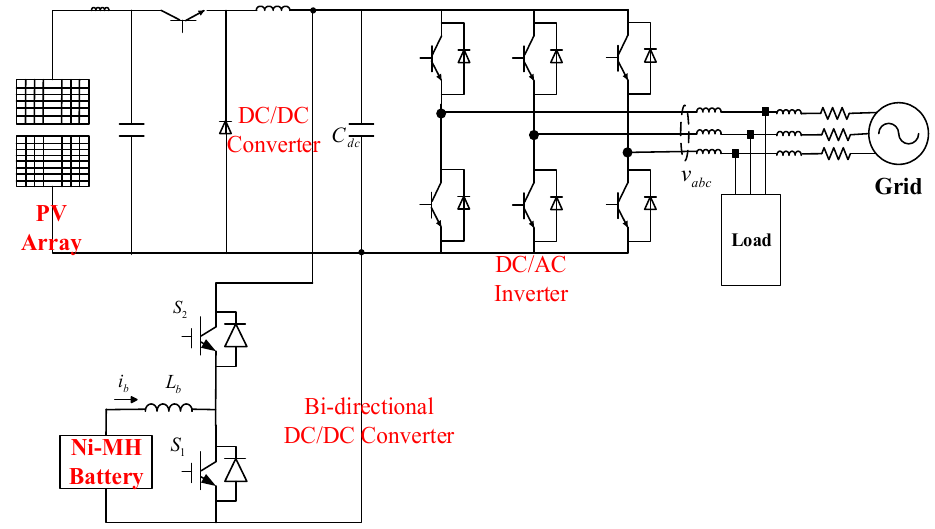
Figure 22. Configuration of PV battery hybrid systems.